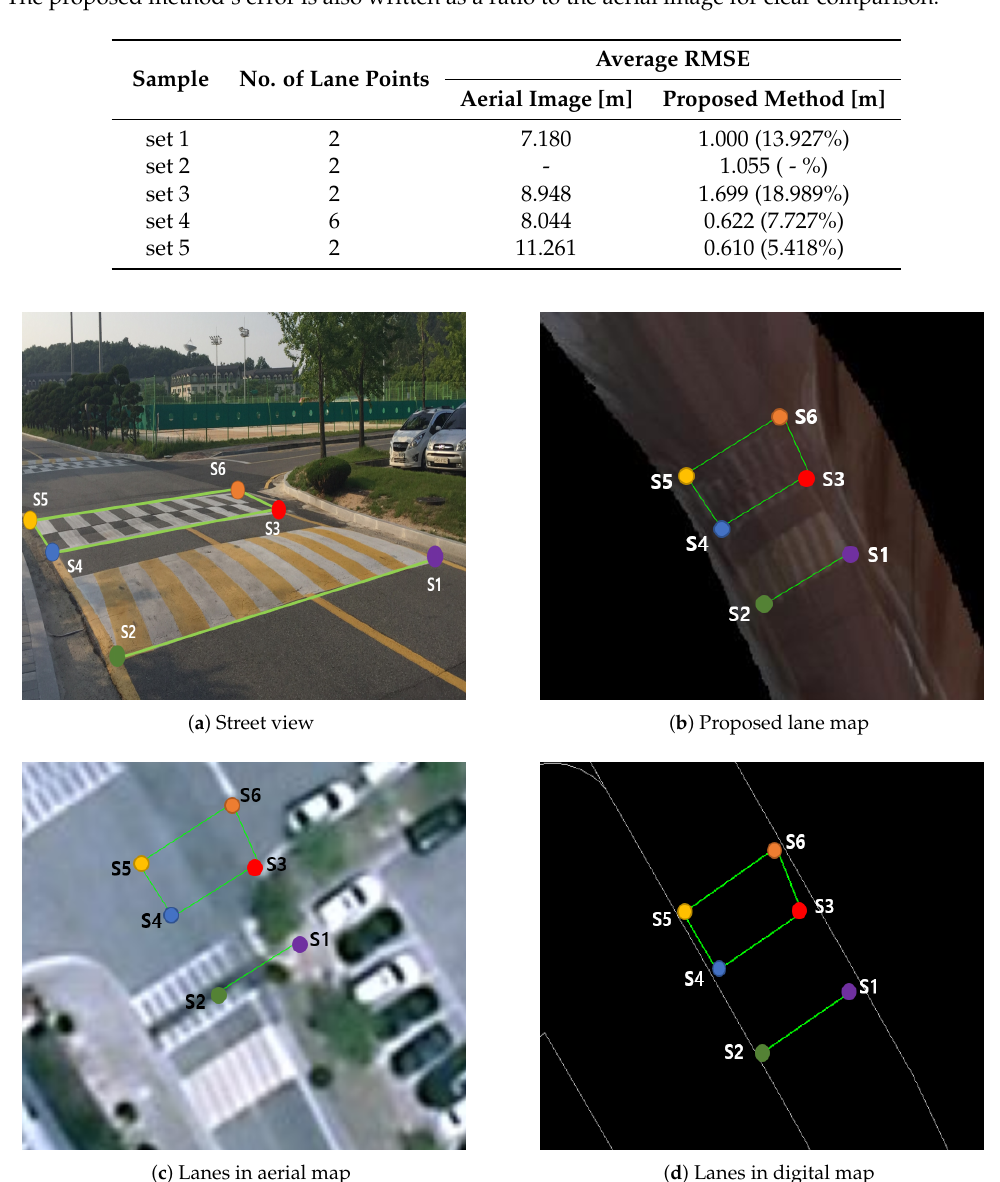
Figure 19. Six sample points having accurate global position are measured by RTK-GPS, and they are plotted on ( a ) street view, ( b ) lane map, ( c ) aerial map and ( d ) digital map. ( c ) Substantial position error with ground truth in aerial map, ( d ) Small position error with ground truth occurs, but lacking in detail such as road mark and cross walk. ( b ) Proposed method has position accuracy with global ground truth and detail